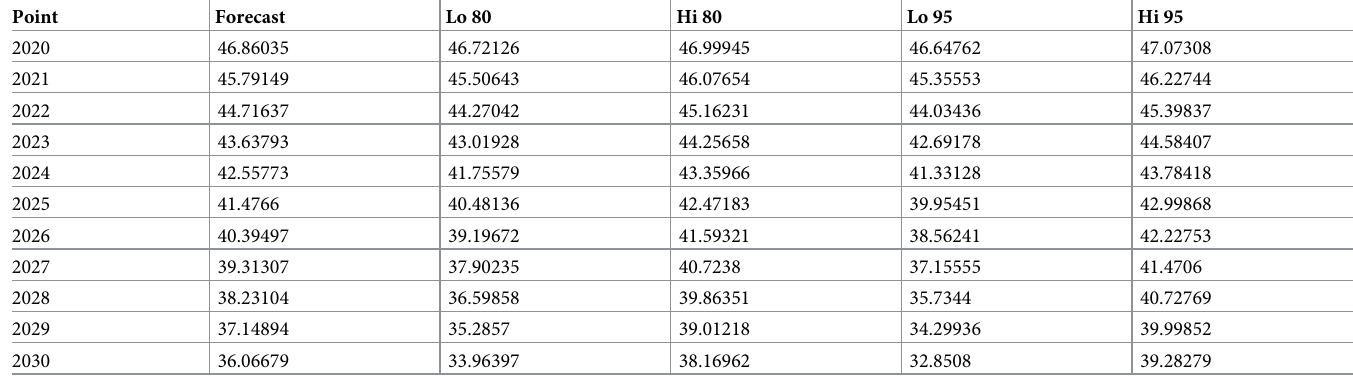
Table 8. Future value for age dependency ratio using ARIMA (1,2,1).